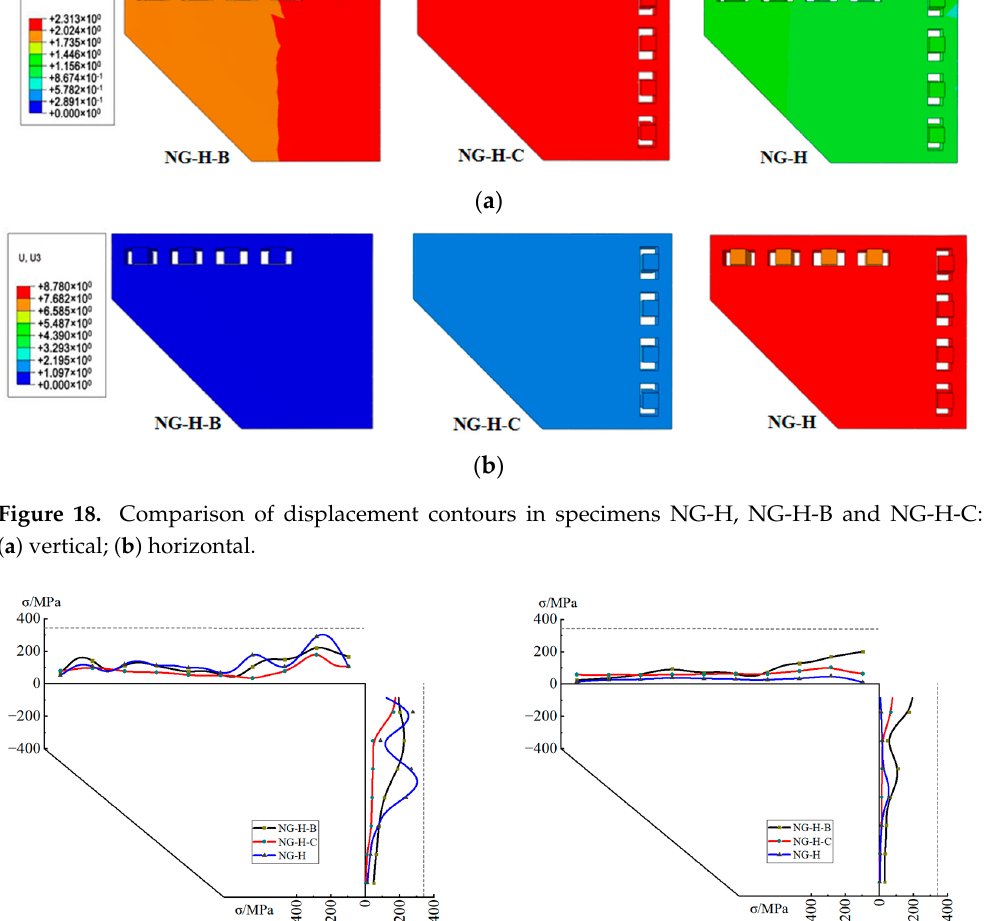
Figure 19. Comparison of Von Mises stress distributions for specimens NG-H, NG-H-B and NG-H- C: ( a ) Joint closing; ( b ) Joint opening. ( a ) Joint closing; ( b ) Joint